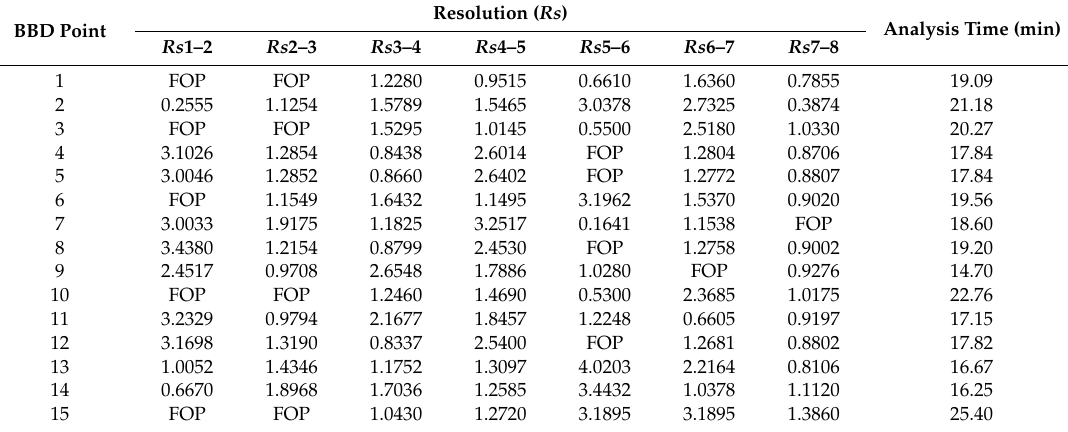
Table 2. Observed responses of BBD by HPLC-DAD.